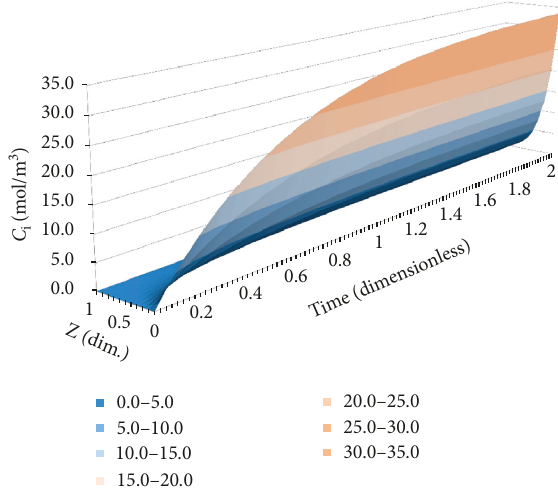
+ concentration profile. 3